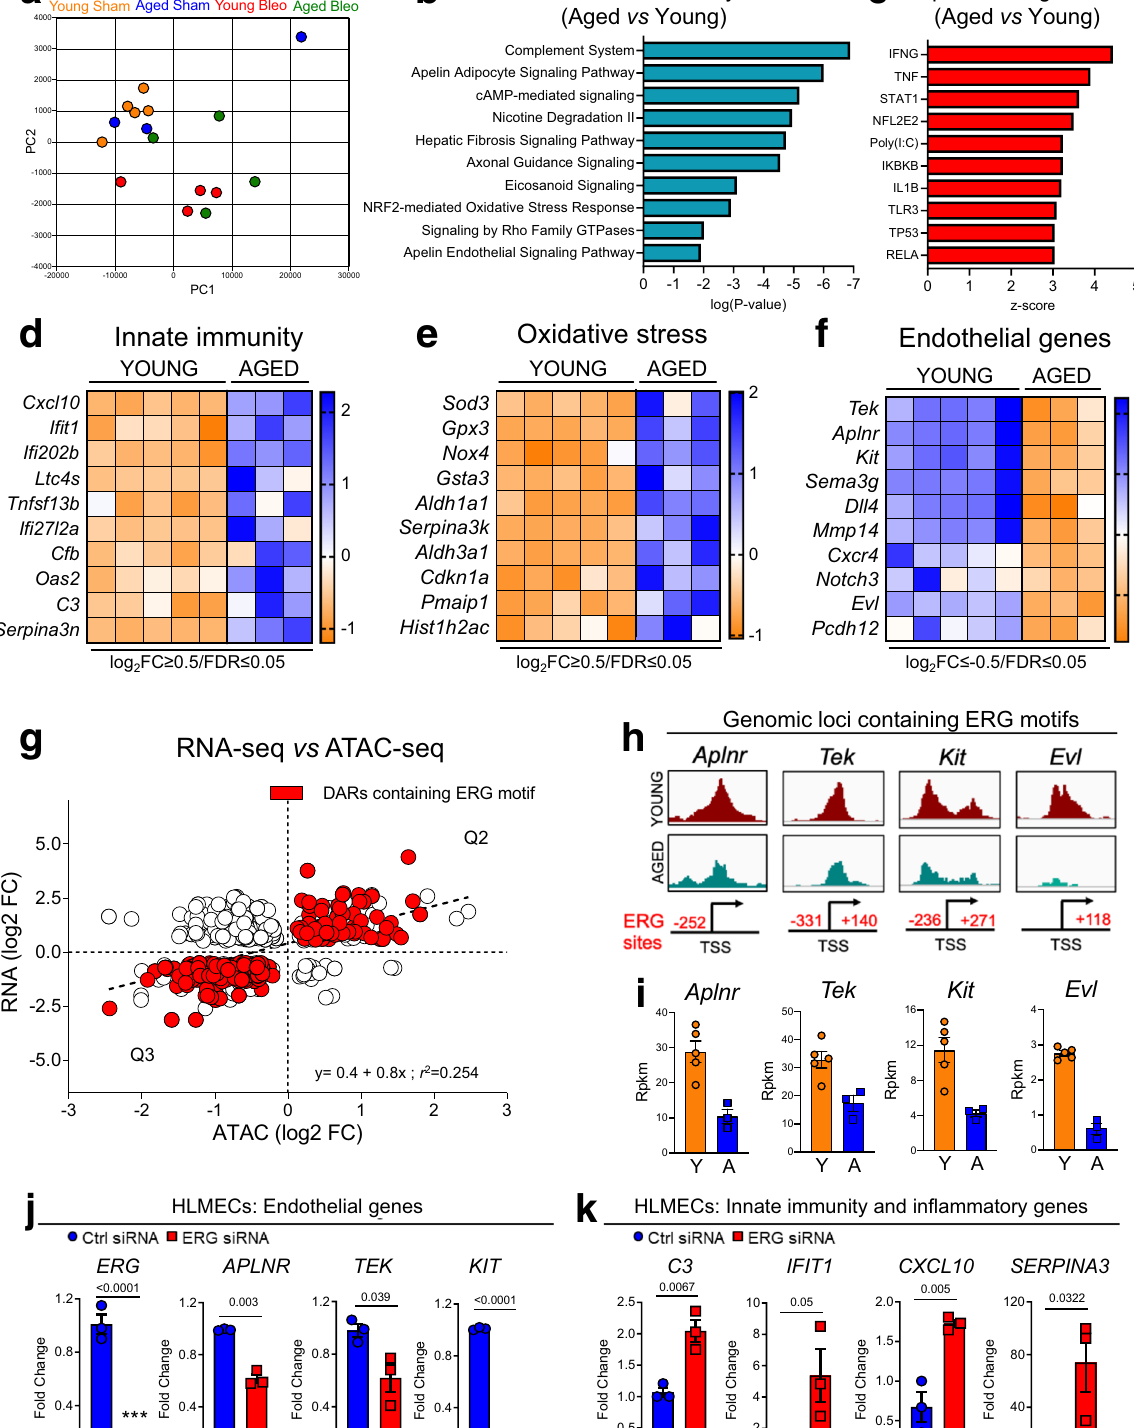
migration, including Cdh13 , Evl , Nov , and Mmp14 (Fig. 4g), as well as basement membrane formation, such as Lama4 , Col4a1 , Dcn , and Hspg2 (Fig. 4h), was strongly elevated in injured young ECs but not in injured aged ECs. ATAC-seq and RNA-seq correlation together with motif enrichment analysis revealed that the large majority of differen- tially expressed genes positively correlated with